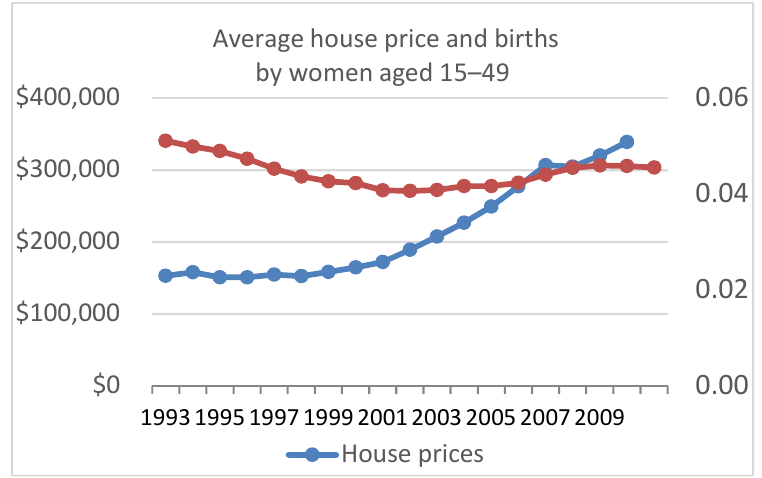
Figure 1: Canadian average house price and births by women aged 15–49, 1993–2010